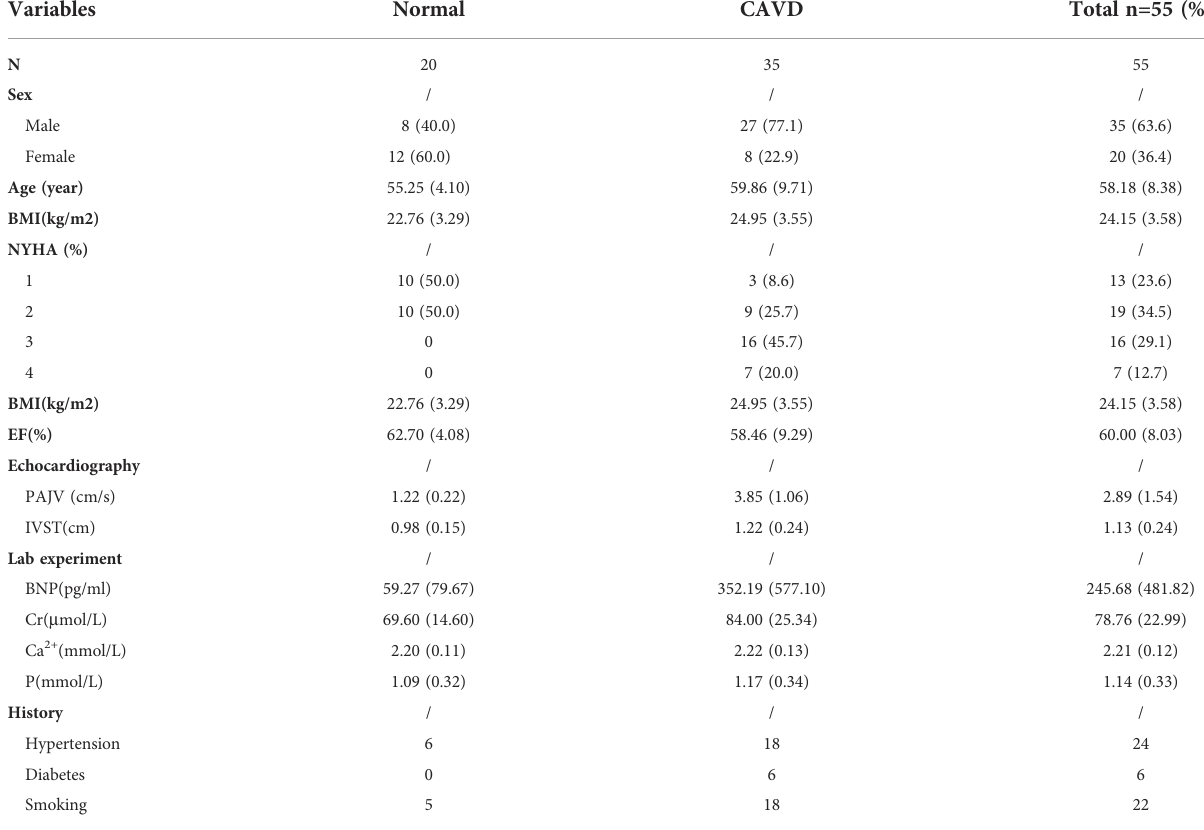
TABLE 1 The detailed information on each